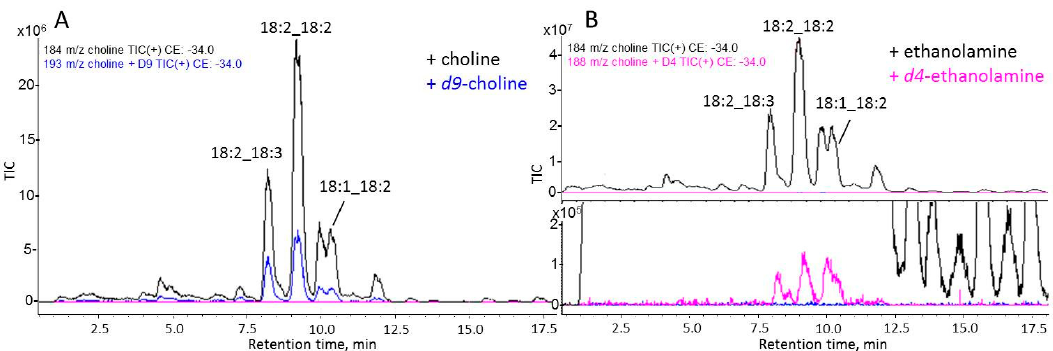
Figure 9. LC-MS/MS precursor ion scan (TIC) chromatogram. Data observed from the targeted analysis of d9 -choline ( A ) and d4 -ethanolamine ( B ) incorporation in PC. PE molecular species were detected by the loss of a neutral fragment of m/z 141, corresponding to the phosphoethanolamine head group. Mass spectra of d 4 -ethanolamine-labeled PE included fragments corresponding to the neutral loss of 145.